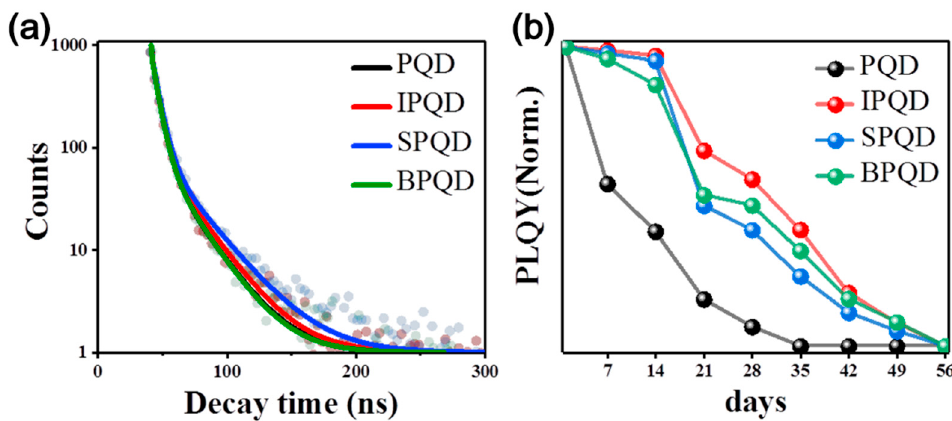
Figure 3. ( a ) Time-resolved PL decay with fitting curve of ( b ) stability of 0 mol%, 3 mol% In, 3 mol% Sb, and 1 mol% Bi ion substituted CsPbBr 3 perovskite QDs.